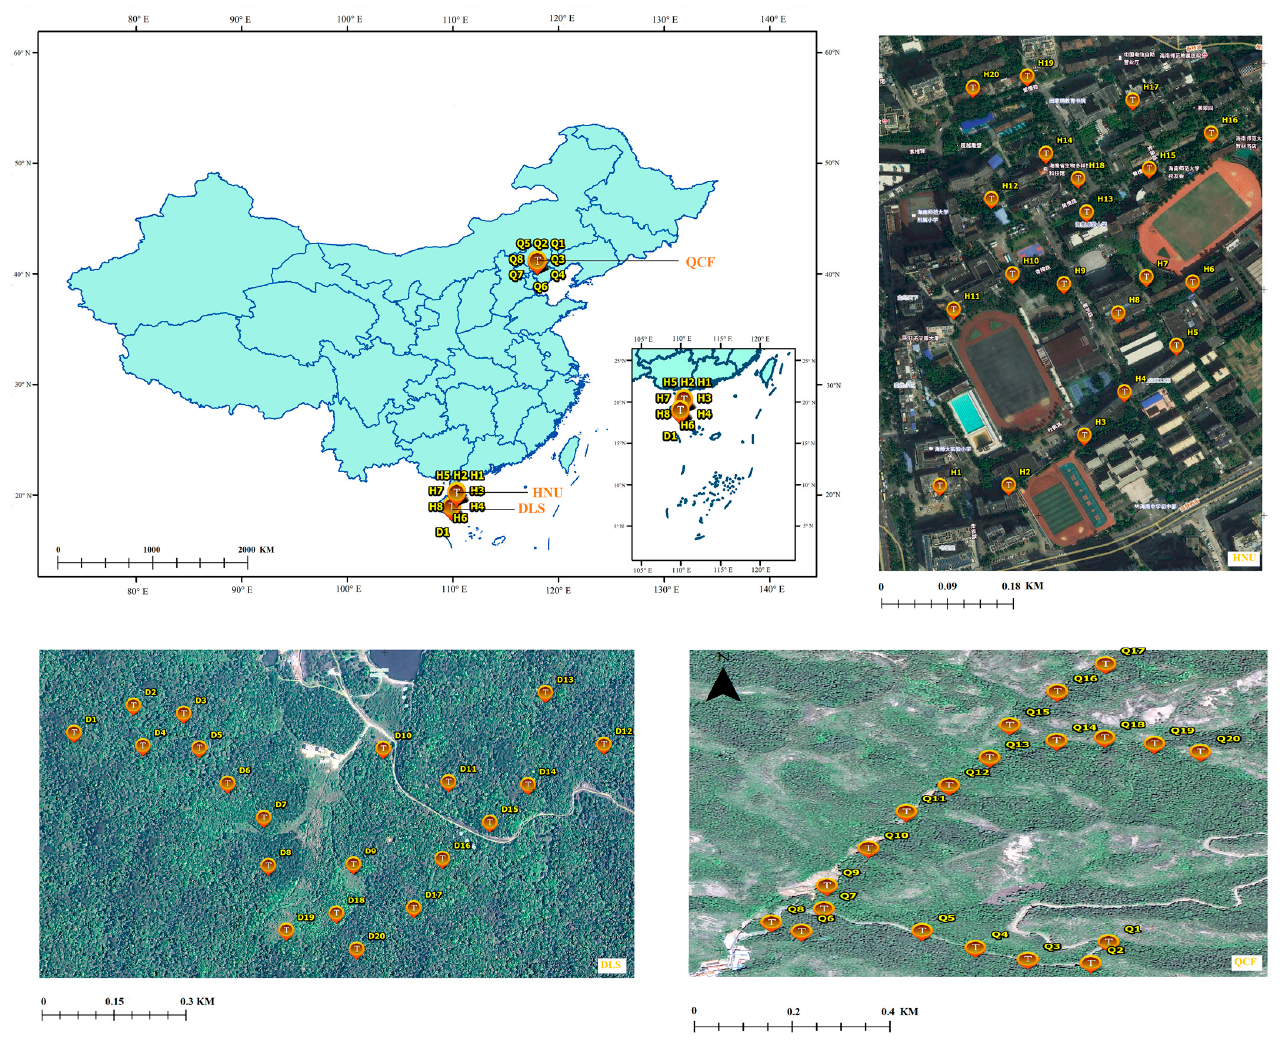
Figure 1. The study area (Q1–Q20 indicates the nest box sample site of QCF; H1–H20 indicates the nest box sample site of HNU; D1–D20 indicates the nest box sample site of DLS). DLS (18°43 ′ –58 ′ N, 109°43 ′ –110°03 ′ E, with a total area of approximately 37,900 ha and